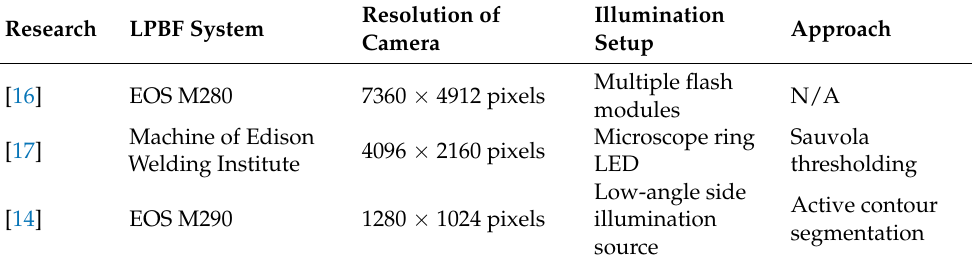
Table 1. Research setups using optical powder bed